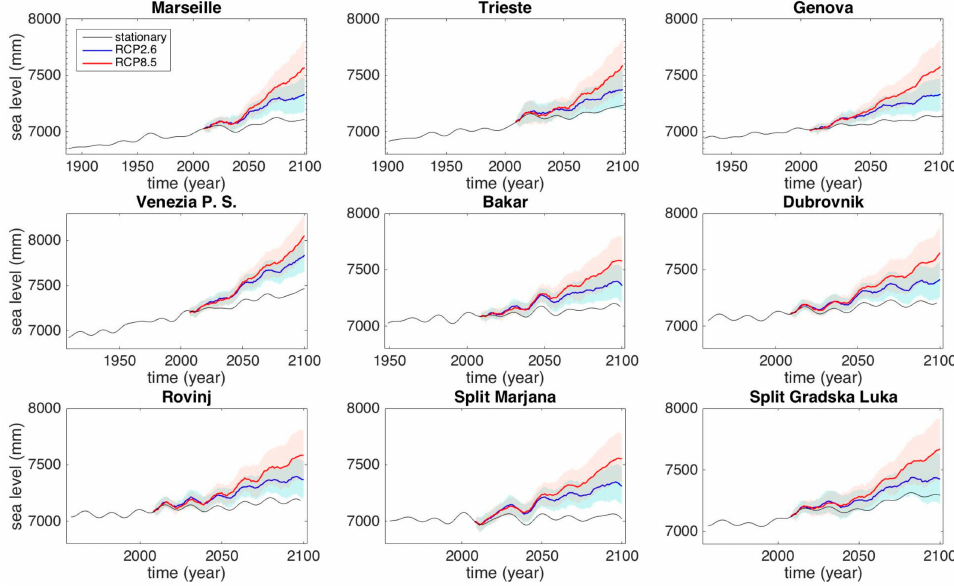
Figure 7. Sea-level height up to 2100 for the analyzed stations, as obtained by the model of Equation (4) that includes VLM and AR5 RCP2.6 (blue line) and RCP8.5 (red line) rate. Color bands represent the 90% confidence interval, obtained by including uncertainties from the model, VLM, and AR5 trend. The black line represents sea levels when the constant trend obtained from fits is used. Since cGPS data are not reliable, the contribution of VLM is not included for Bakar and